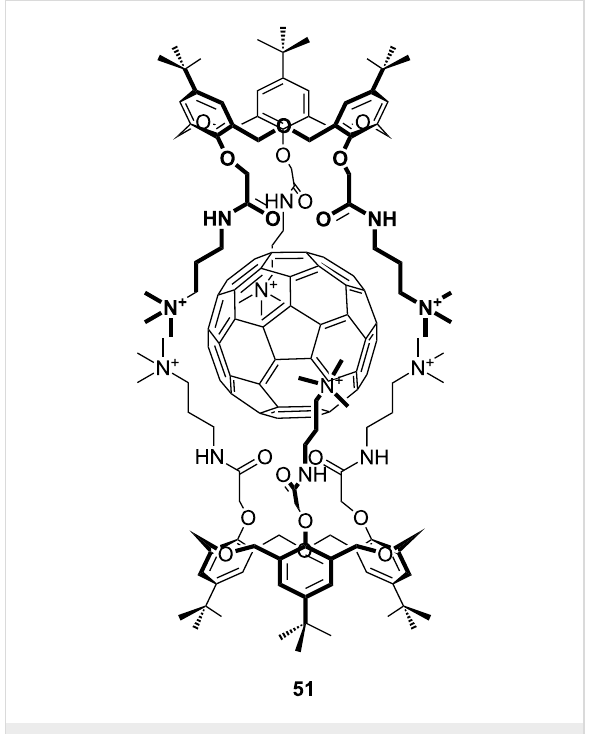
Figure 26: A C 60 complexing cationic oxacalix[3]arene 51 [81].